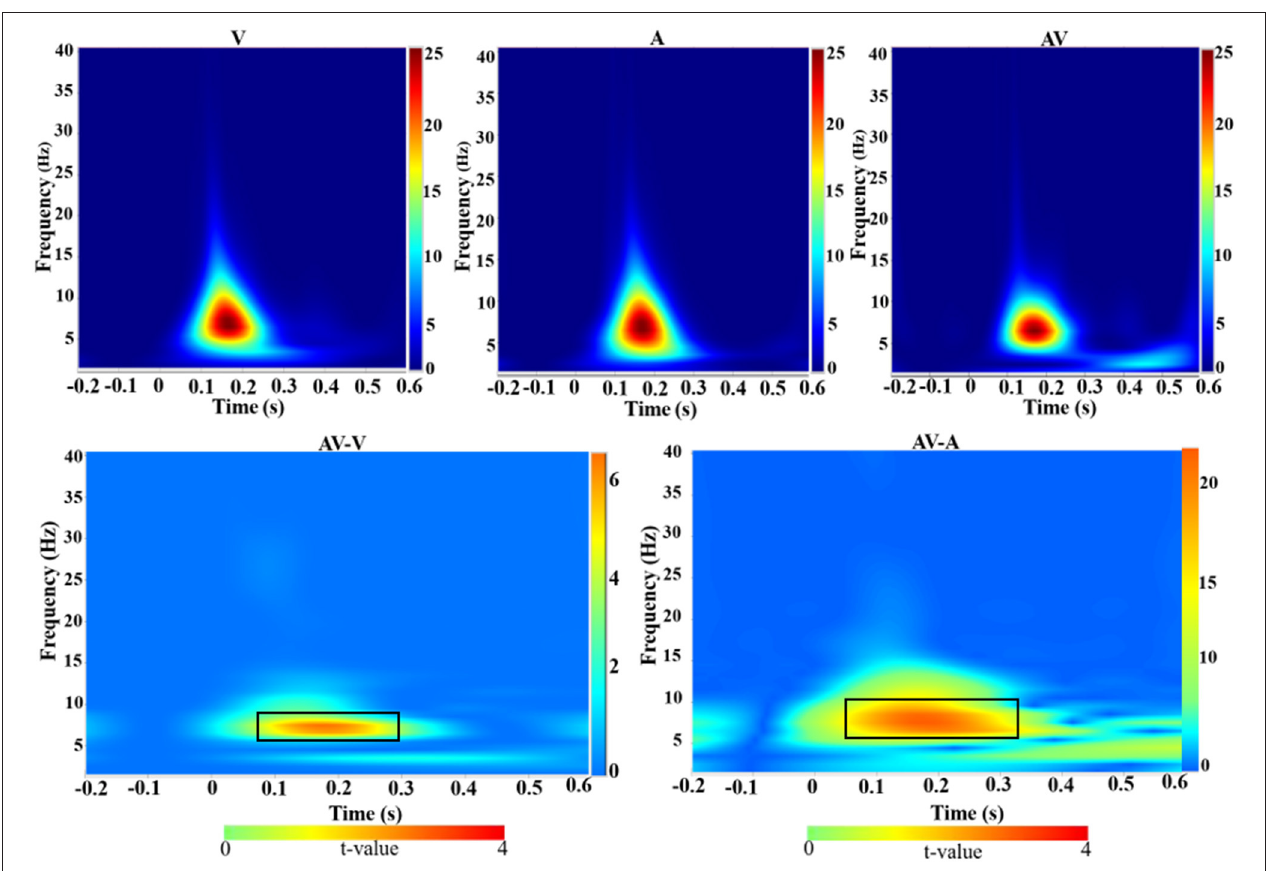
FIGURE 4 | Group-averaged time-frequency spectra during the three conditions (V, A, and AV) and comparisons of the conditions (AV vs. V and AV vs. A). Time (in seconds) is denoted on the x -axis, with 0s defined as the onset of the encoding stimulus. Frequency (in Hz) is shown on the y -axis. All signal power data are expressed in a logarithmic scale, with the color legend shown to the far right (unit: dB). Statistical values ( t values) of time-frequency representation comparisons of the conditions are also shown with the color legend at the bottom. The top panel shows that theta activity increased during the encoding stage (110–270ms) across the three conditions (V, A, and AV). The bottom panel, marked with a black box, shows the differences in theta activity between the AV and V conditions and between AV and